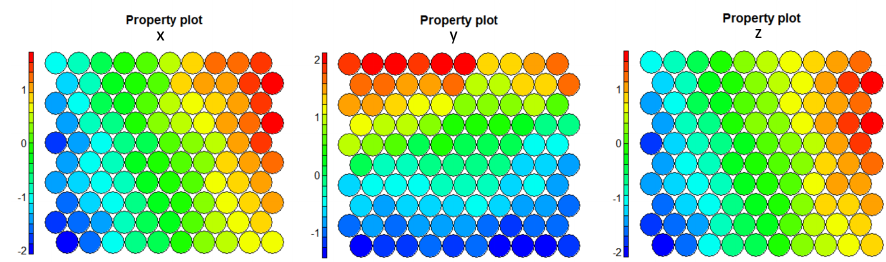
Figure 17. Two-layer SOM, last layer, final maps for coordinates x, y, z,